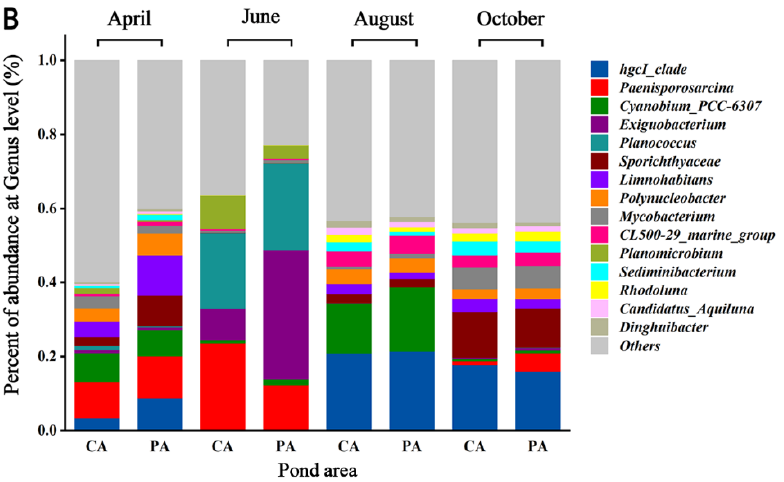
Figure 3. Relative abundance of microbial communities at Phylum ( A ) and Genus ( B ) levels.